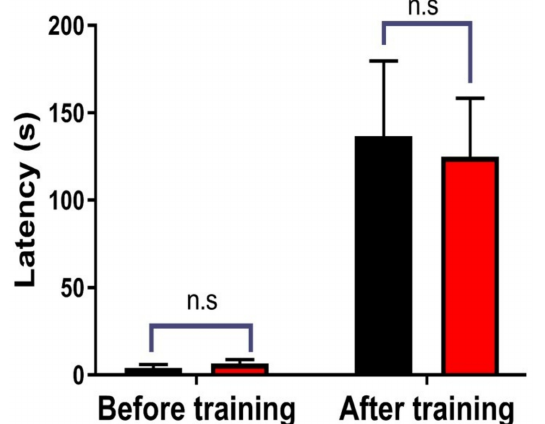
Figure A2. Passive avoidance test on training and memory of control (black) and C 60 NPs (red) treated zebrafish after nine-day exposure. Data were presented as means ± standard error of the mean (SEM) ( n = 12) and analyzed individually for each treated group. Statistical analysis was performed by one-way ANOVA, followed by Tukey post hoc test. n.s.: